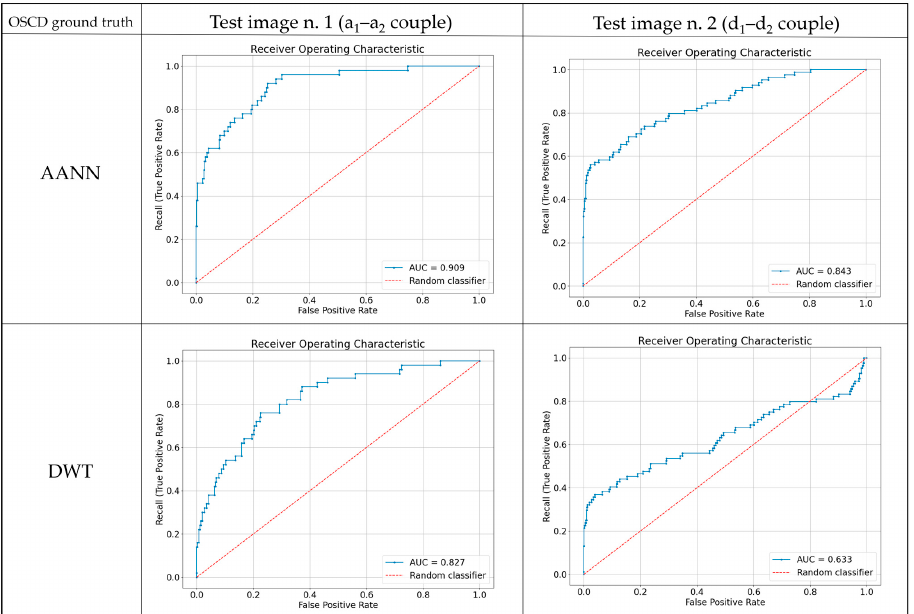
Figure 16. ROC curve for test image 1 in Figure 11(a 1 ,a 2 ) ( left ) and test image 2 in Figure 11(d 1 ,d 2 ) ( right ). OSCD ground truth image.